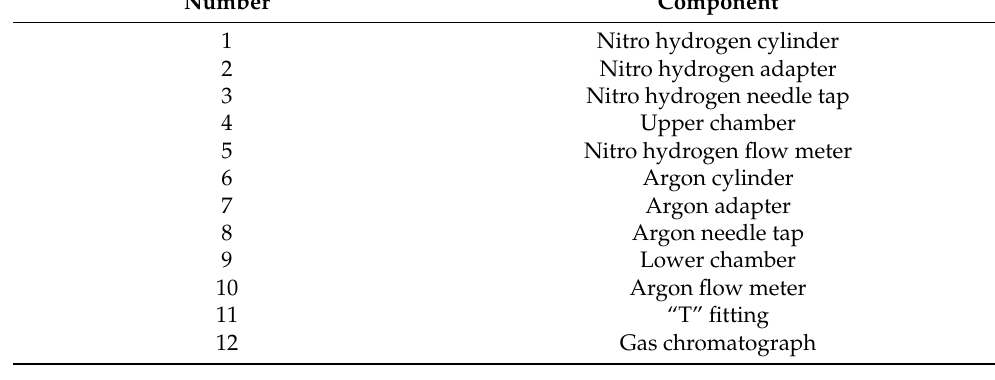
5 of 11 Table 1. Legend of hydrogen permeability test bench. Number